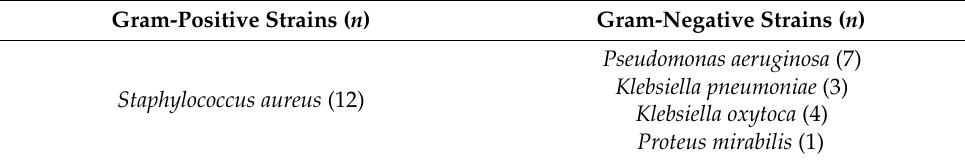
Table 1. Bacterial strains used in the